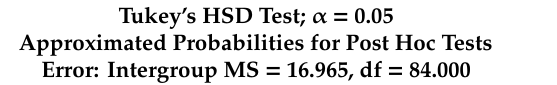
Figure 14. Standard aeration efficiency (SAE) in the tested barbotage reactor.